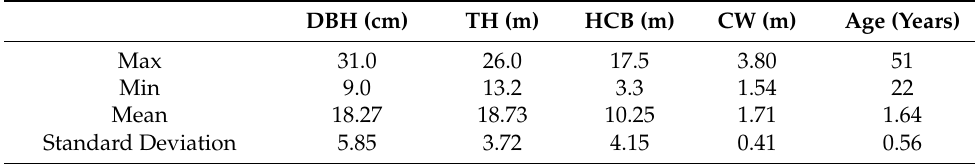
Table 2. Basic characteristics of the selected tree